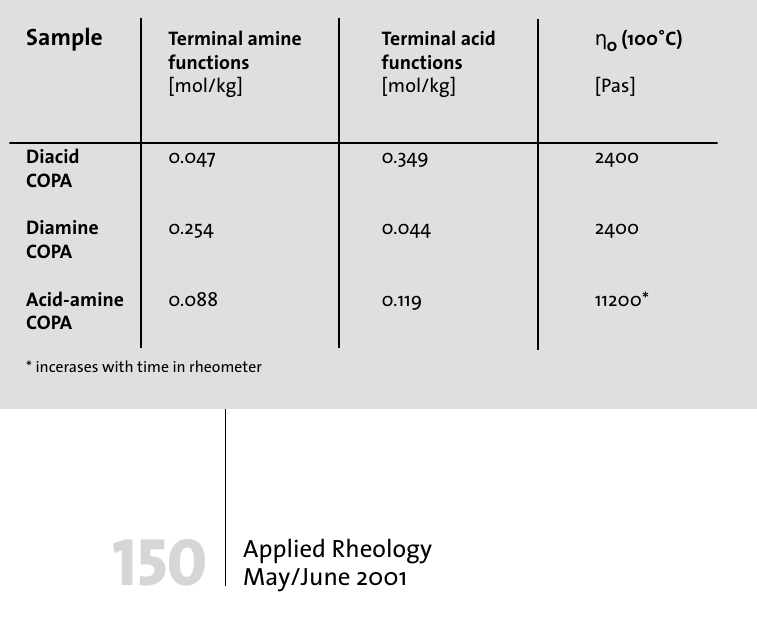
Table 5: Concentration of terminal acid and amine functions and zero-shear viscosity at 100°C of the copolyamides of Part